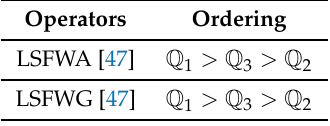
Table 6. Ordering of the